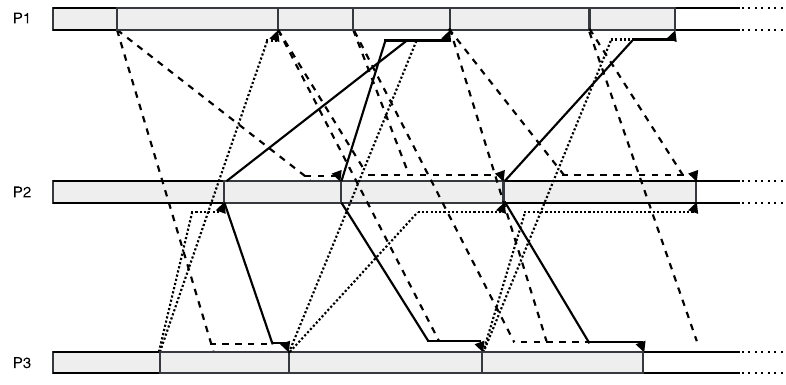
Figure 1. Example of asynchronous iterations with asynchronous communication.